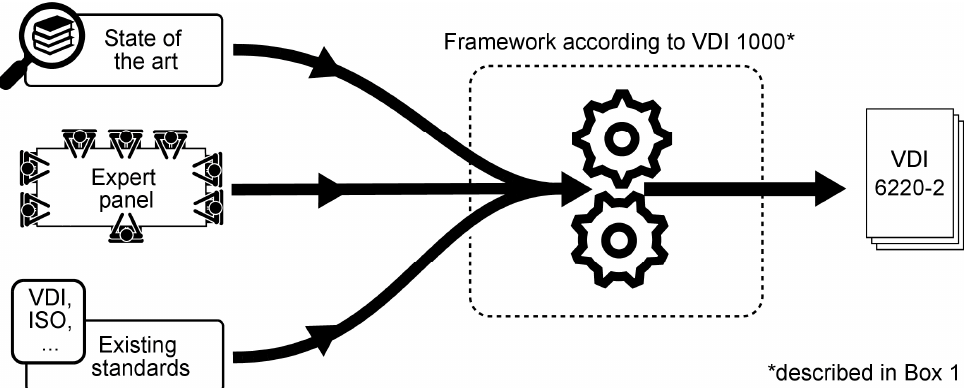
Figure 2. Flow diagram of the working process that led to VDI 6220 Part 2.